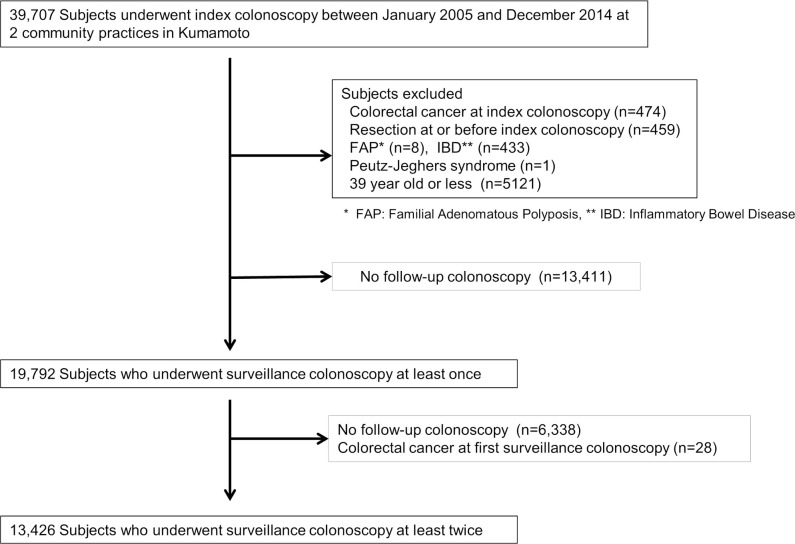
Flowchart of enrollment in this study.